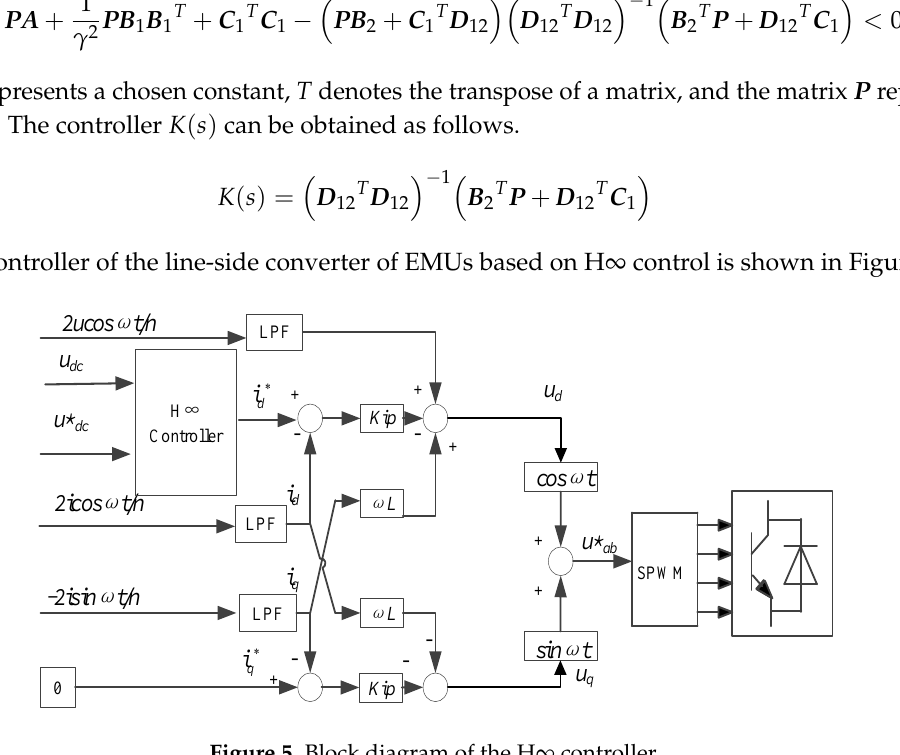
Table 1. Parameters of the weight function and optimal values.